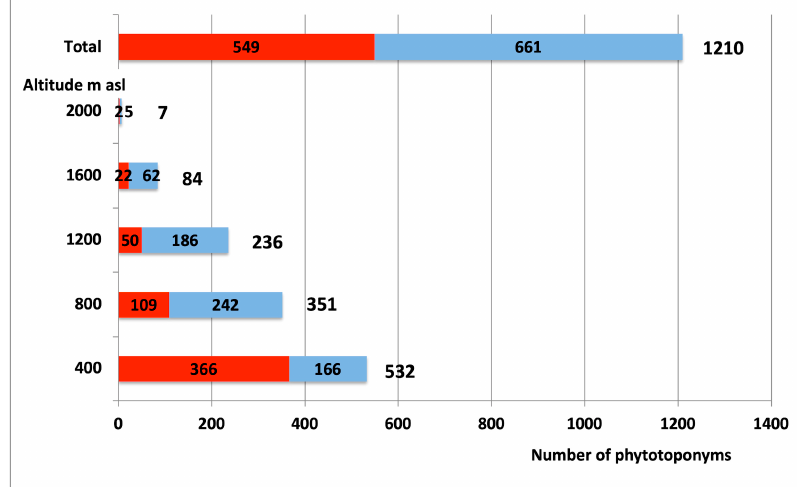
Figure 6. Distribution of phytotoponyms by altitudinal belt and agreement with current forest vegetation. In blue, correspondence between phytotoponyms and forest vegetation, in red no correspondence.